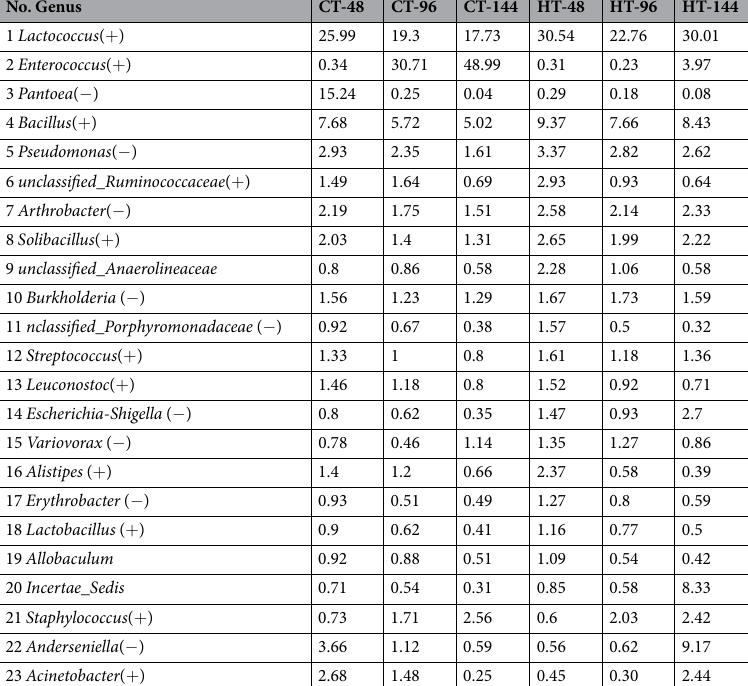
Table 4. Proportion of genera in the intestinal bacterial community at different time points in all samples. + , Gram-positive bacterium; − , Gram-negative bacterium.